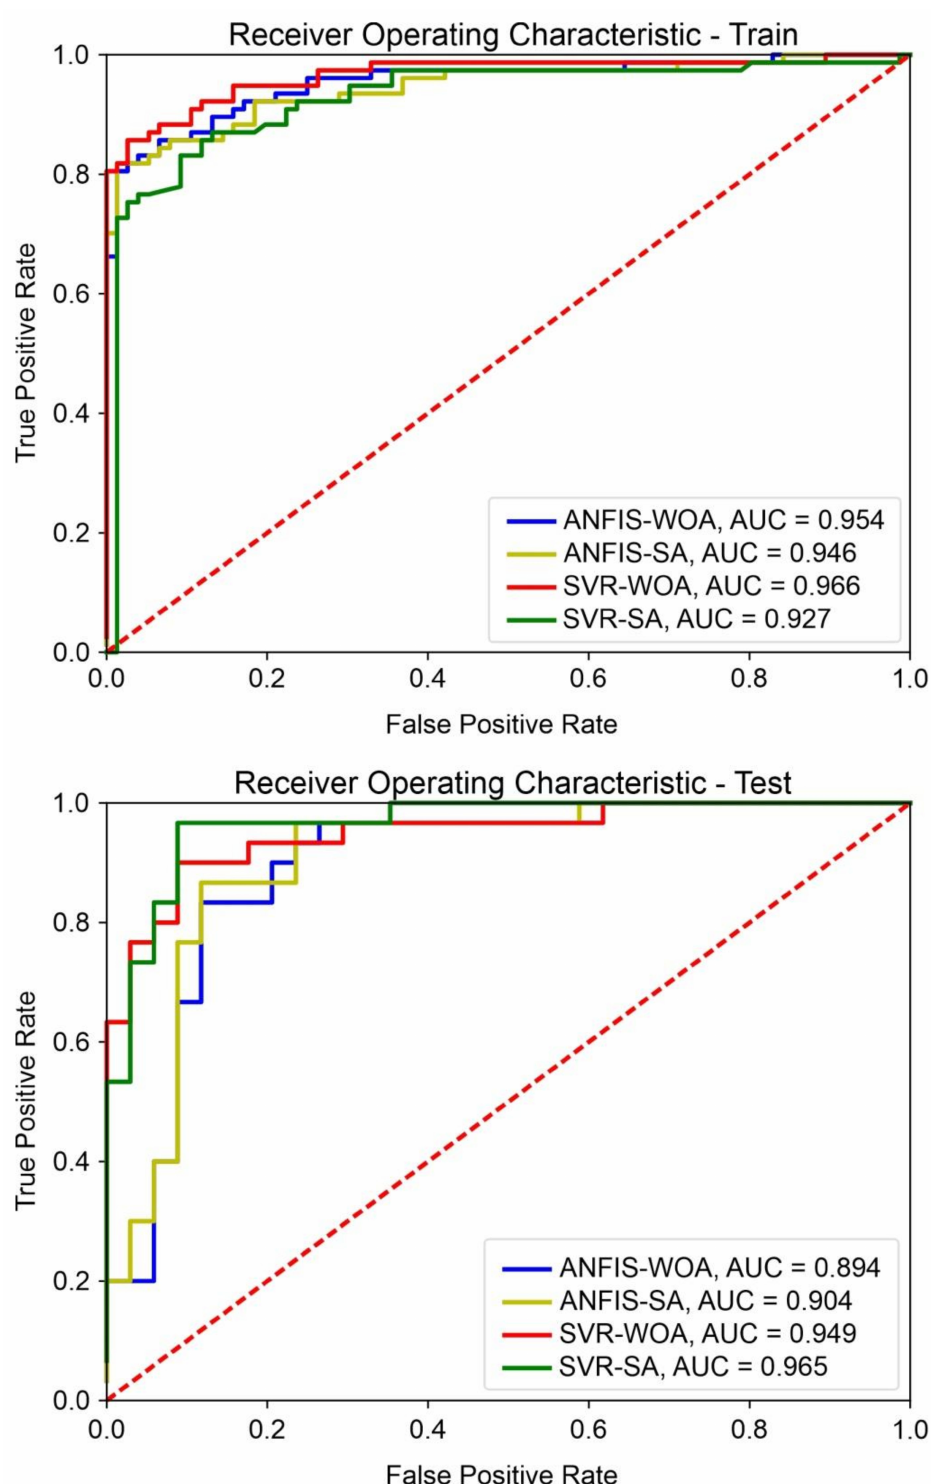
Figure 8. The ROC curves for four hybrid models in the training and testing